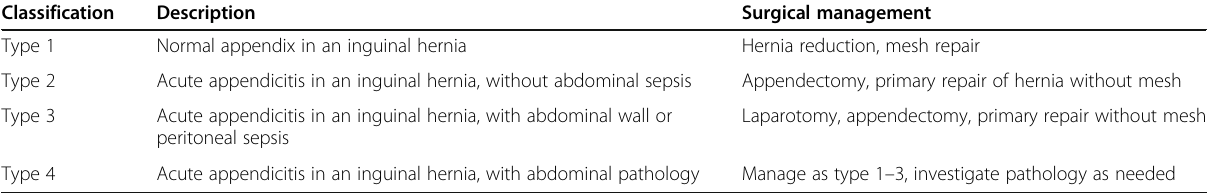
Table 1 Losanoff and Basson classification of Amyand ’ s hernia with their surgical management